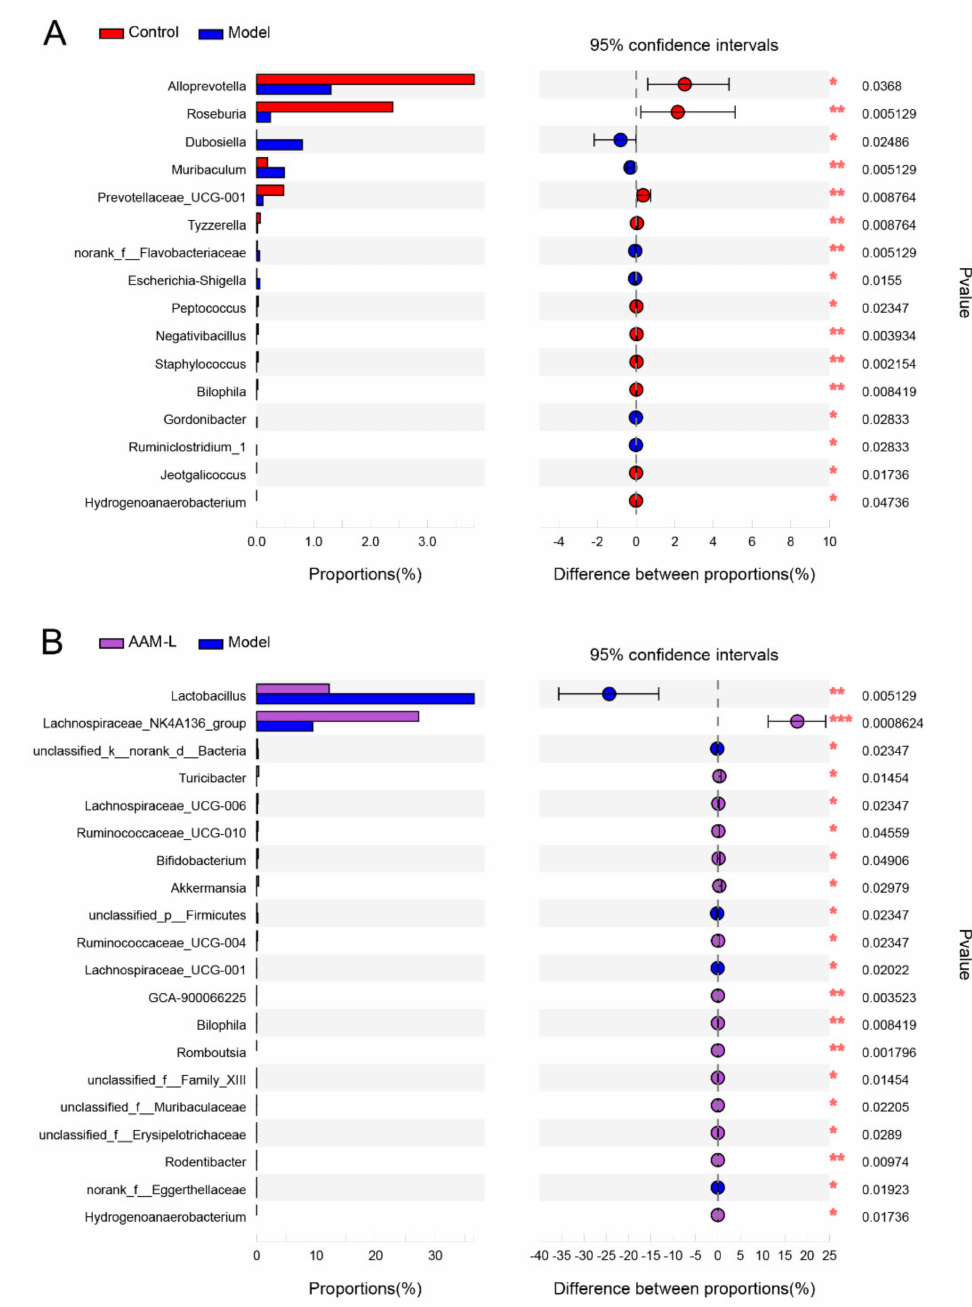
Figure 5. Effect of AAM administration on intestinal microbial population in mice exposed to alcohol intake for consecutive 6 weeks. ( A ) The Control group versus the Model group; ( B ) The AAM-L group versus the Model group; *** p < 0.001, ** p < 0.01 and * p <